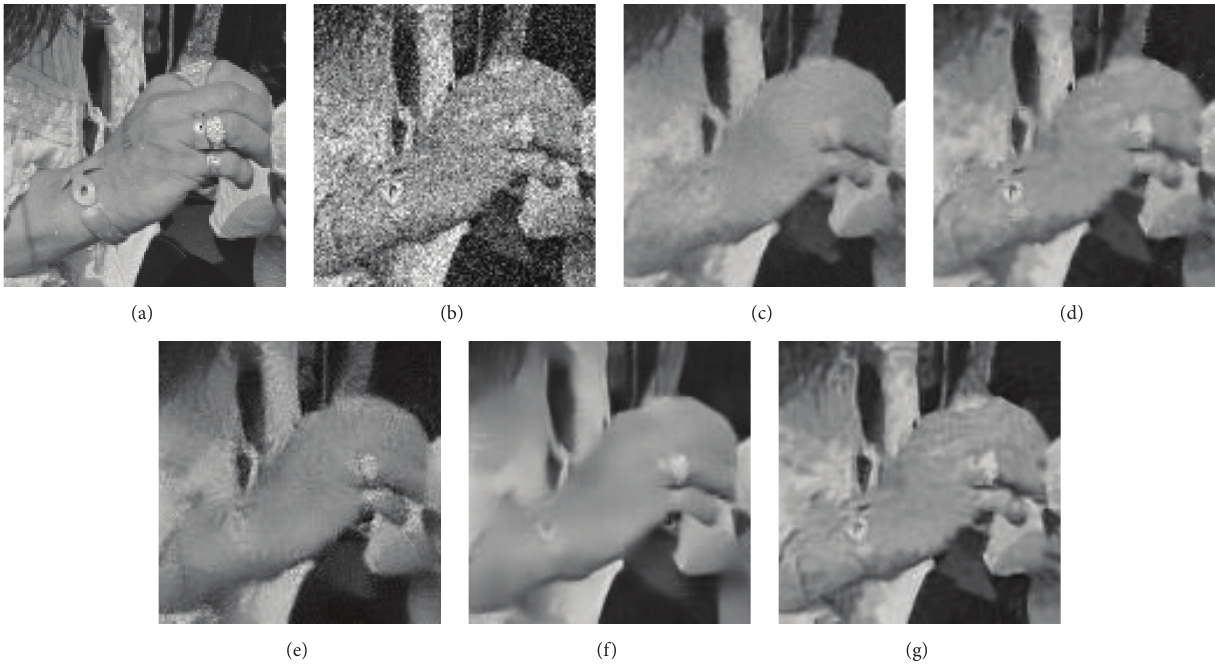
Figure 4: Detailed comparison of the proposed approach with other approaches on image Man with 𝜎 = 30 : (a) is the noise-free image; (b) is the corrupted image; (c)–(f) are the denoising results by NLM, NL-TV, NLMPCA, and NLMSAP; (g) is the denoising result by the proposed 𝑙 0